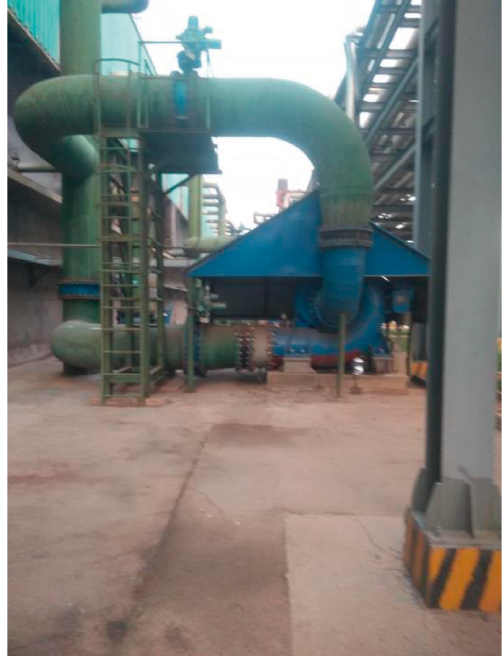
Figure 1: Test units.